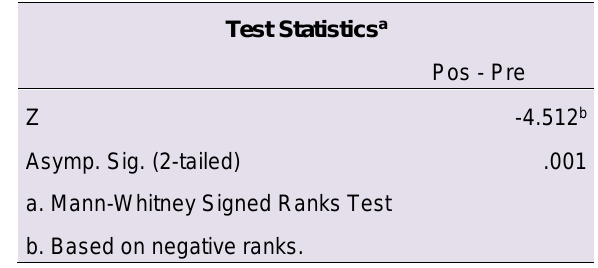
Table 5 . The Mann-Whitney